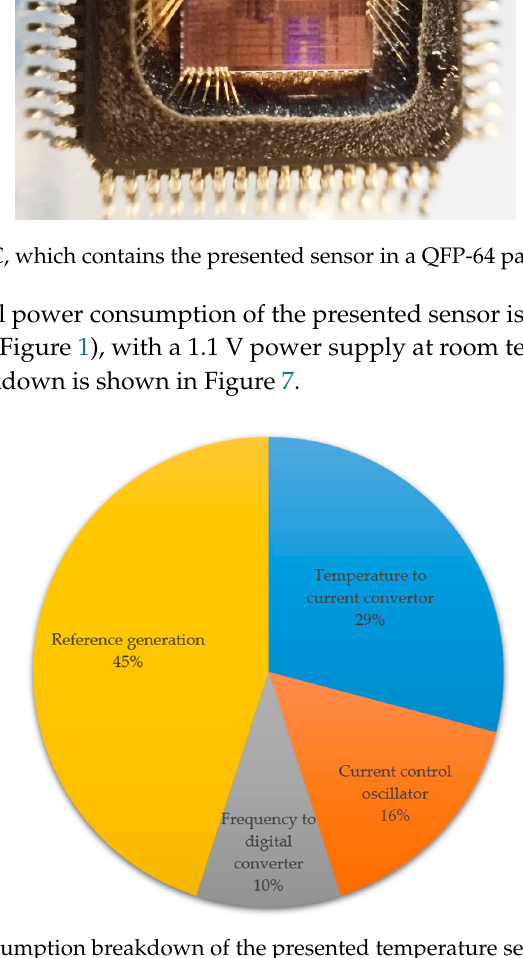
( b ) Figure 8. Experiment setup: ( a ) the PCB used to the test the sensor in the SoC in a QFP64 package; ( b ) the measurement PCB in the chamber.